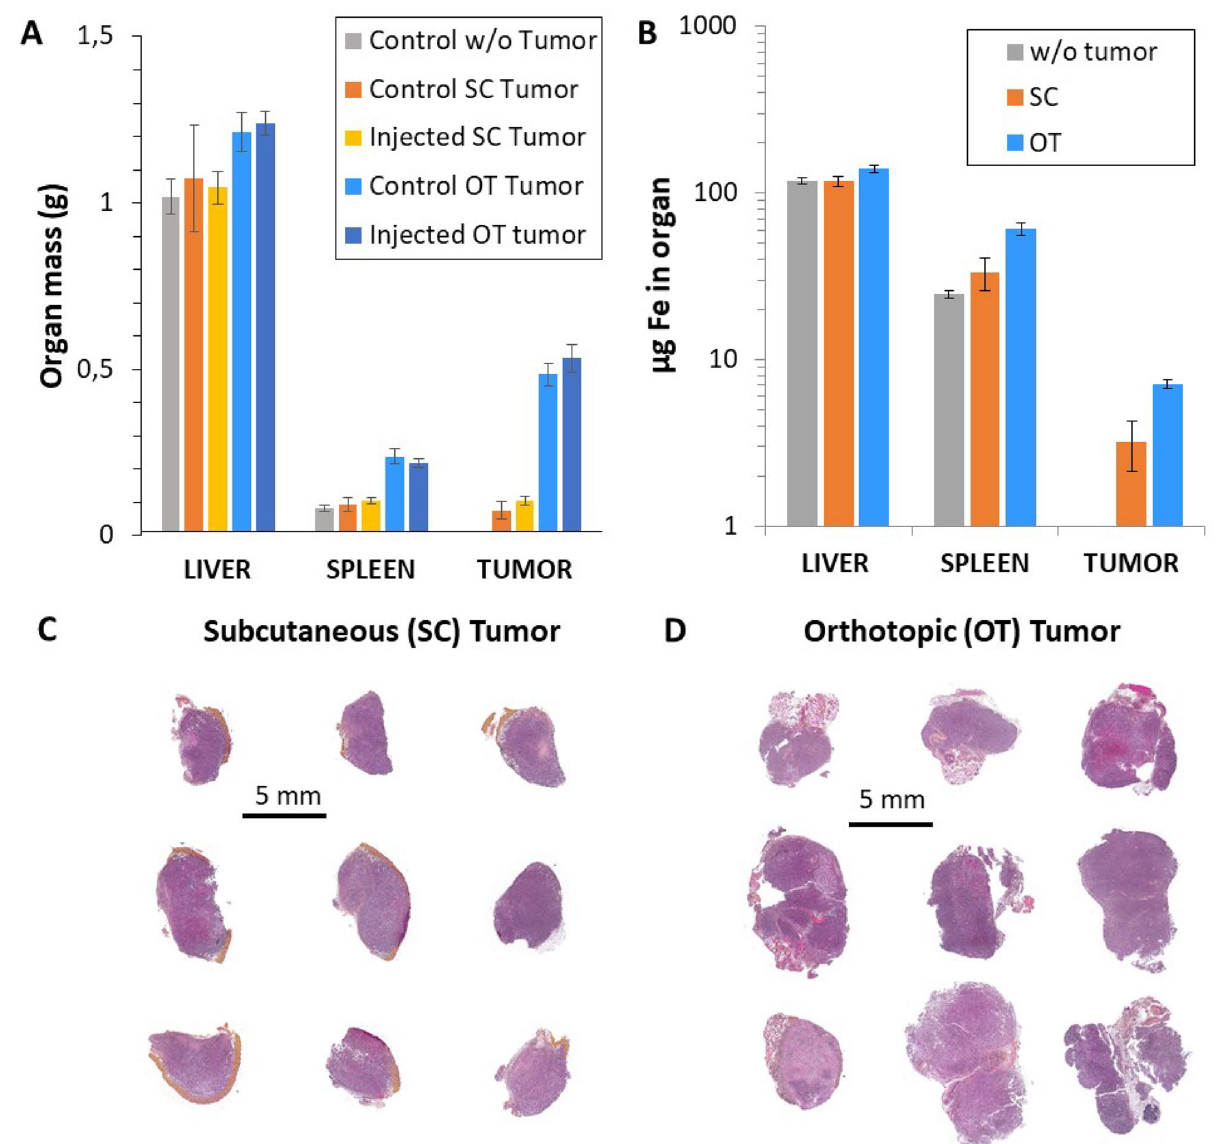
Figure 1. Subcutaneous (SC) versus orthotopic (OT) tumor models. ( A ) Organ mass in grams for liver, spleen and tumor 4 and 7 days after injection for OT and SC models, respectively. ( B ) Iron content (µg Fe) in liver, spleen and tumor of the control mice for the two induced models ( n = 6 for SC; n = 5 for OT). ( C ) and ( D ) Histological slides of SC and OT tumor models, field moment units, show a similar trend (Fig. 2D) as the amount of total iron. Given the magnetic moment of the ultramagnetic liposomes, estimated at 67 emu/g, we calculated the proportion of injected dose in terms of magnetic moment, shown in Fig. 2E. In contrast, for the OT tumor models, an approximate 2-fold increase of the administered dose can be found upon magnet application (from around 1 to 2% of the administered dose). The accumulation of liposomes in both tumor models following magnetic targeting is shown in Fig. 3. Trans- mission electron microscopy and Prussian Blue histological tissue staining shows a low accumulation of nano- particles in SC tumors (Fig. 3A,C). On the other hand, nanoparticles were readily identifiable in OT tumors, and were even observed in vessels and within single cancer cells (Fig. 3B,D). Supplementary images of both tumor models show a similar trend (Supplementary Information Figs. 2, 3 and 4). Scarcely any nanoparticles were found for both tumor tissue models when no magnetic targeting was applied (Supplementary Information Figs. 5 and 6). The same biodistribution analyses were performed with magnetosomes. Figure 4 shows the iron mass quan- tification and magnetometry analysis for both SC and OT tumor models (mice: n = 9 for the SC group, of which n = 5 with magnetic targeting; n = 8 for the OT group, of which n = 4 for magnetic targeting). The magnetosomes (Fig. 4A), of an average diameter of 50 nm (Supplementary Fig. 1), possess a magnetite core resulting in a high magnetization of 8 emu/g. The mass of iron administered was the same as the one used with liposomes, of 558